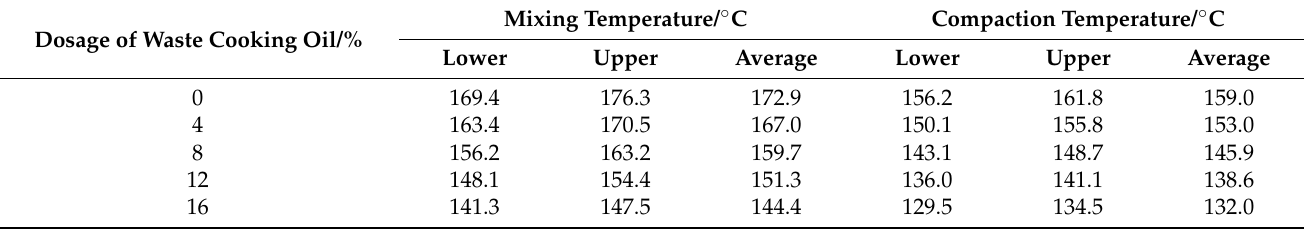
Table 3. Mixing temperature and compaction temperature of SBS-modified asphalt with waste cooking oil